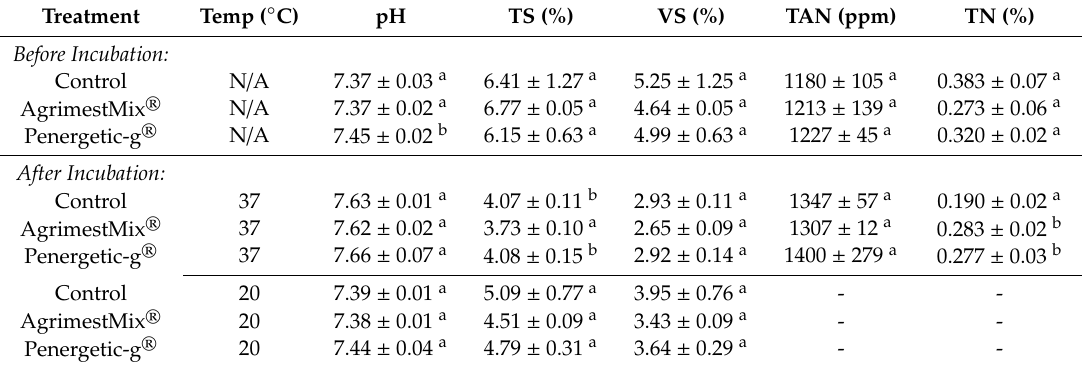
Table 2. Substrate characteristics, pH, total solids (TS), volatile solids (VS), total ammoniacal-N (TAN), and total N (TN) for the control, AgrimestMix ® , Penergetic-g ® , and inoculum treatment before and after the BMP test. Within each group (before incubation, after incubation at 37 ◦ C, after incubation at 20 ◦ C), values followed by the same superscript letter are not significantly di ff